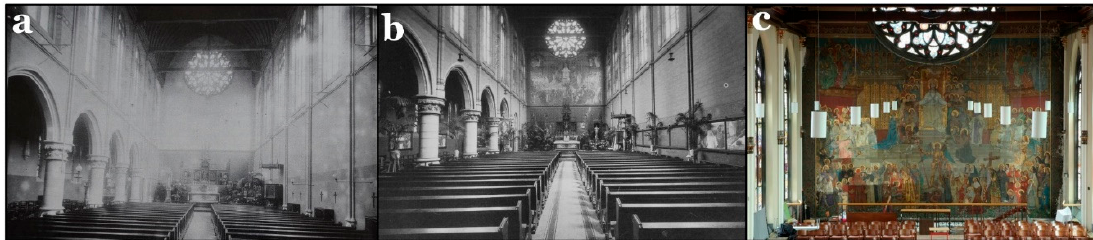
Figure 1. ( a ) A black and white photograph of the chapel in 1897 in the Sint-Jan Berchmanscollege, when the wall painting was not yet executed. ( b ) The chapel in the 1930s, after Ernst Wante created the wall painting. The chapel was not yet divided into two floors at that time [33]. ( c ) A photograph of the wall painting in 2017 showing its state before conservation. The wall painting is now found on the top floor of the chapel.